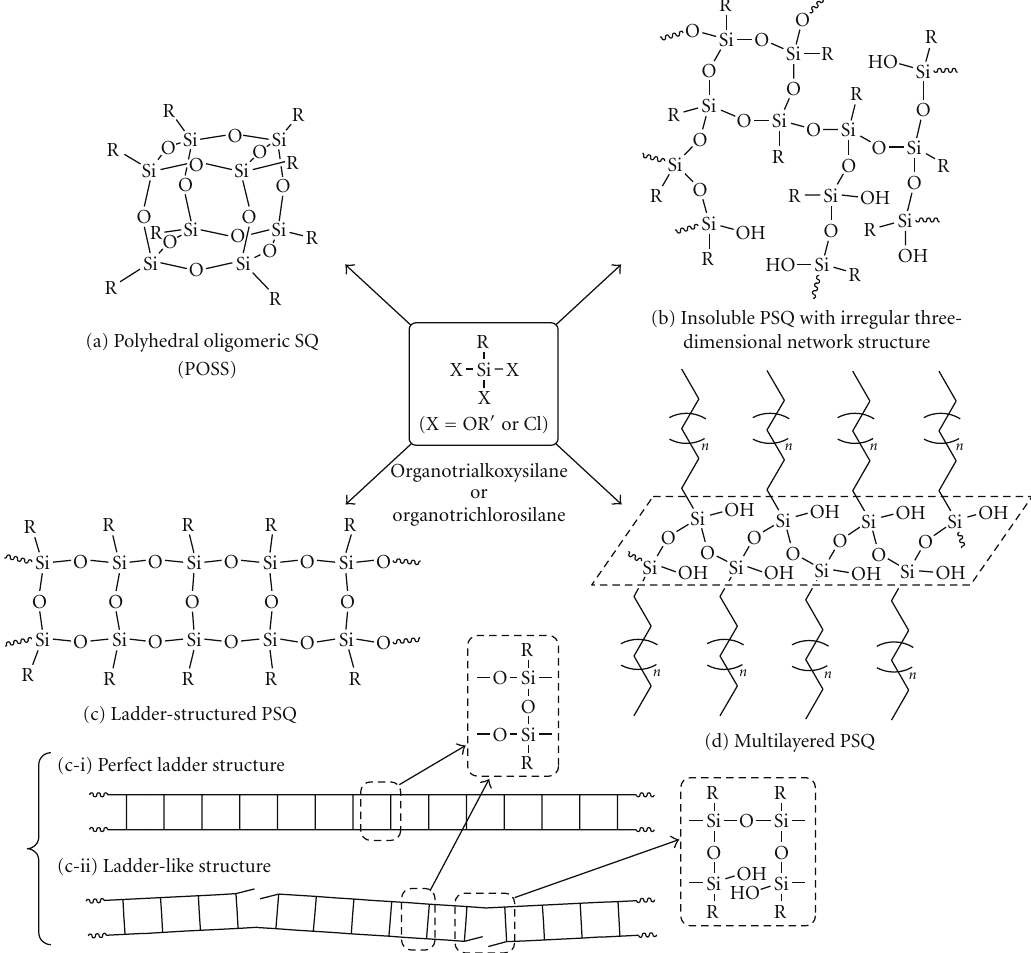
Scheme 1: Preparation of silsesquioxanes (SQs) with various